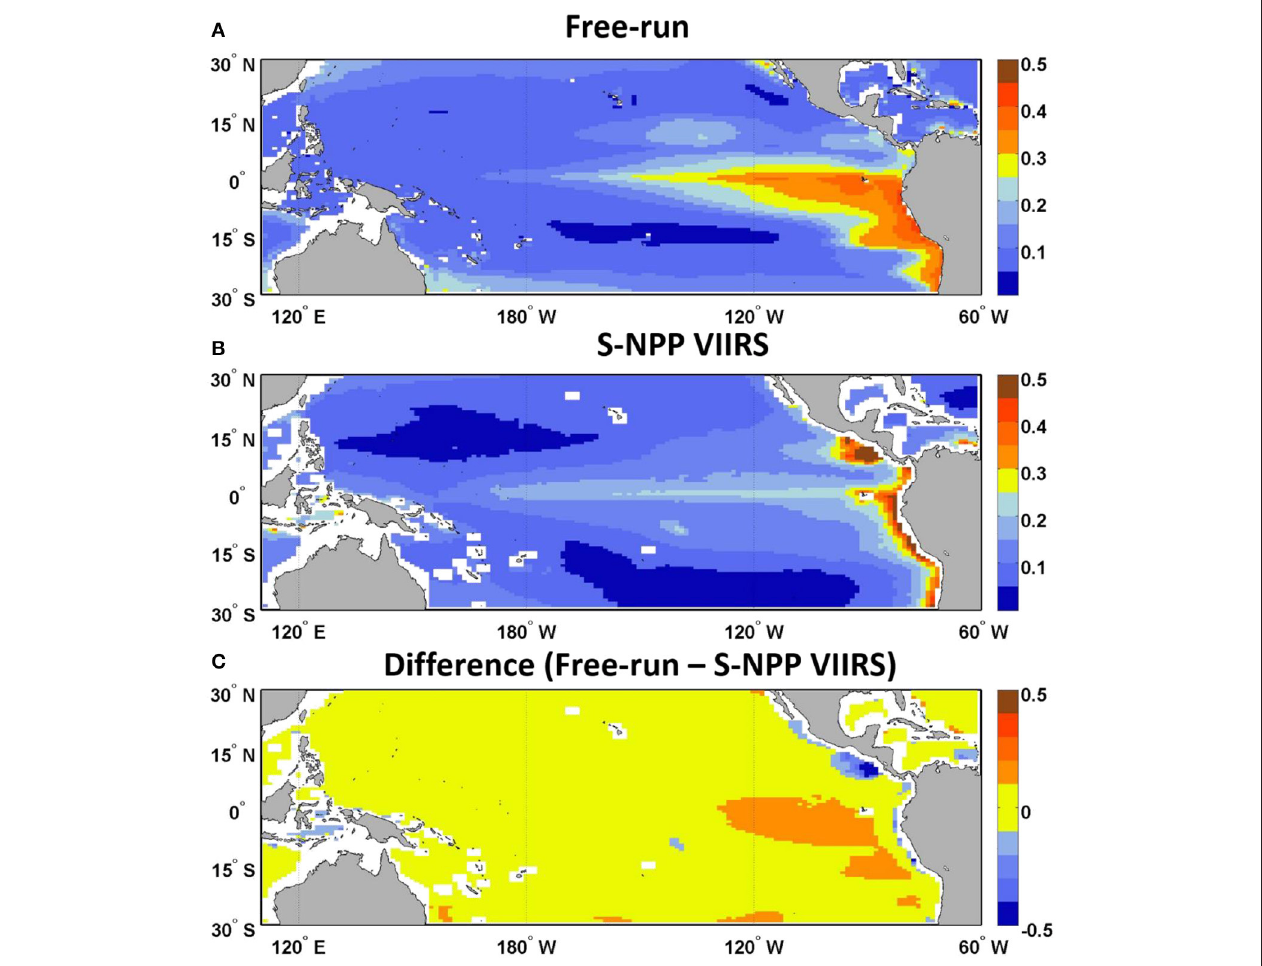
FIGURE 2 | Climatology of chlorophyll concentration ( µ g chl L − 1 , 2012–2015) map of (A) the free-run model, (B) S-NPP VIIRS, and (C) the difference between the free-run model and S-NPP VIIRS in the Equatorial Pacific.